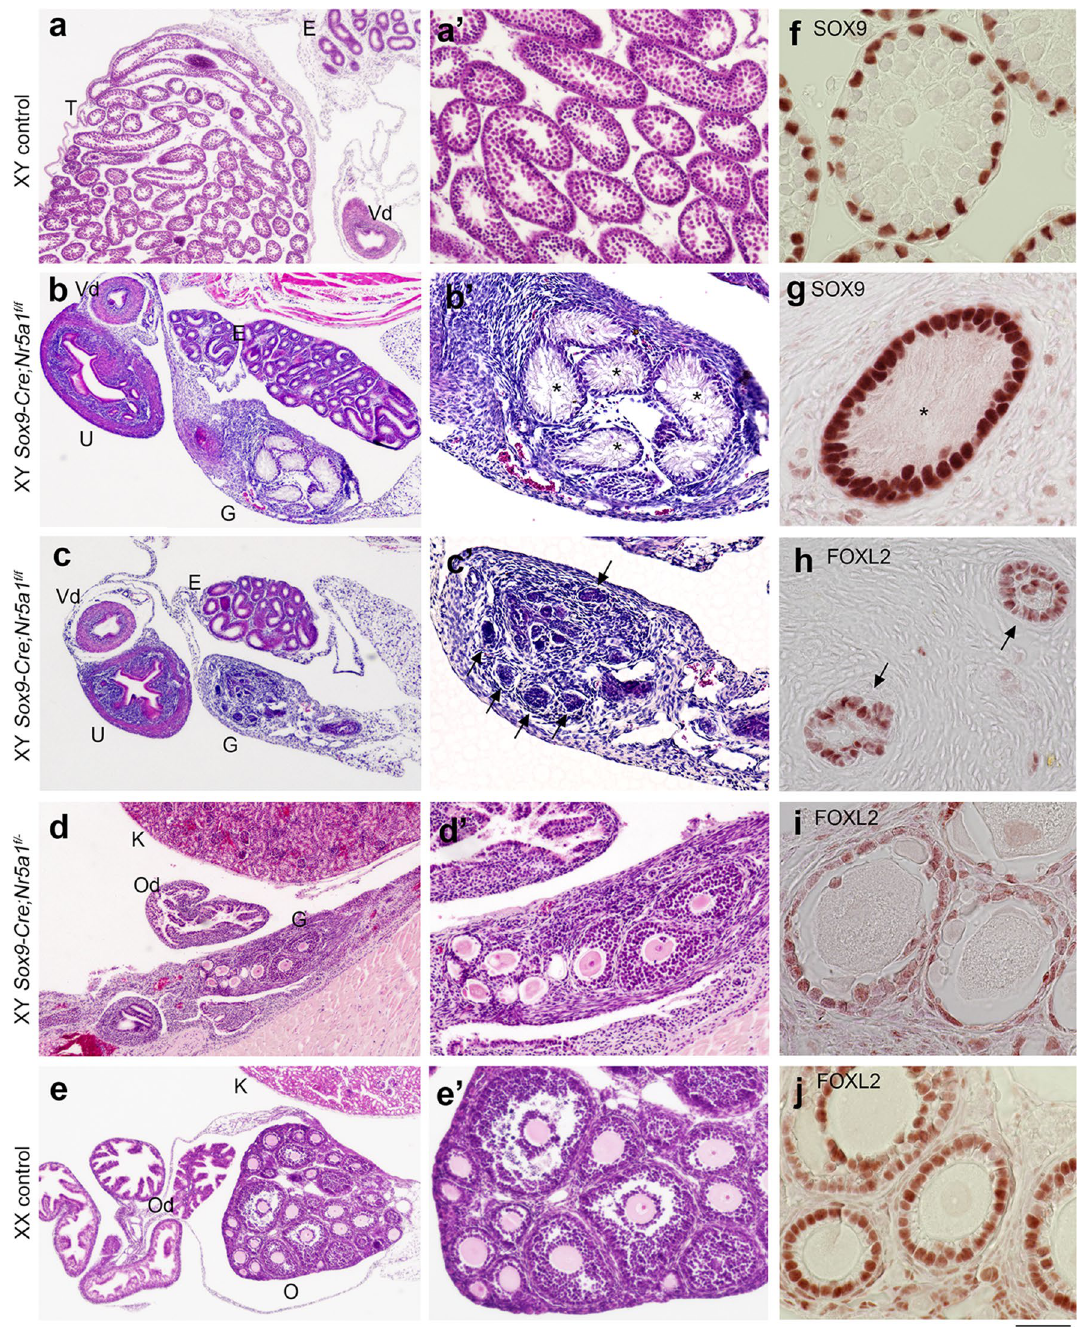
Figure 1. Gonadal phenotypes of postnatal XY Sox9-Cre - Nr5a1 cKO mice. ( a – e ) Haematoxylin and eosin (HE) staining. ( a ′ – e ′ ) Higher magnification views. Representative photomicrographs of XY control ( a ), XY Sox9- Cre;Nr5a1f. /f ( b , c ), XY Sox9-Cre;Nr5a1f. /− ( d ), and XX control ( e ) gonads from 3 week-old animals. ( b ) and ( c ) are from serial sections of the same gonad. ( f – j ) IHC for SOX9 ( f , g ) or FOXL2 ( h – j ). Asterisks in ( b ′ ) and ( g ) and arrows in ( c ′ ) and ( h ) indicate seminiferous tubule-like and ovarian follicle-like structures, respectively. E epididymis, G gonad, K kidney, O ovary, Od oviduct, T testis, U uterus, Vd vas deferens. Scale bar, 250 µm in ( a – e ), 100 µm in ( a ′ –e ′ ), 25 µm in ( f–j